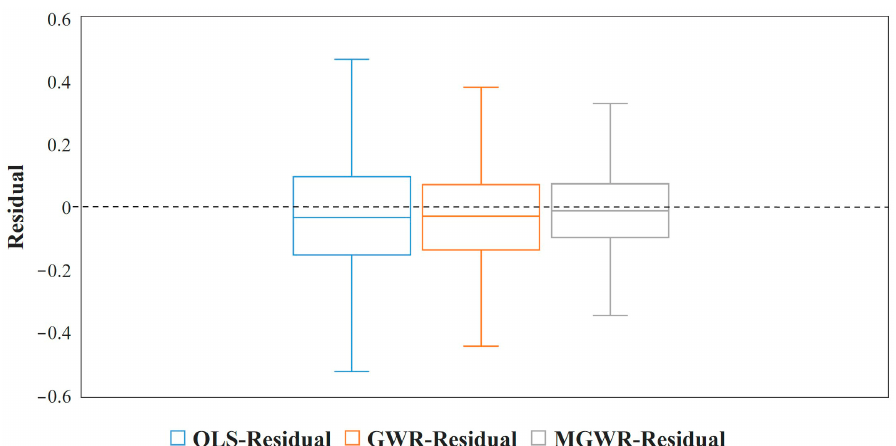
Figure 4. Box plots of the three models’ residuals.